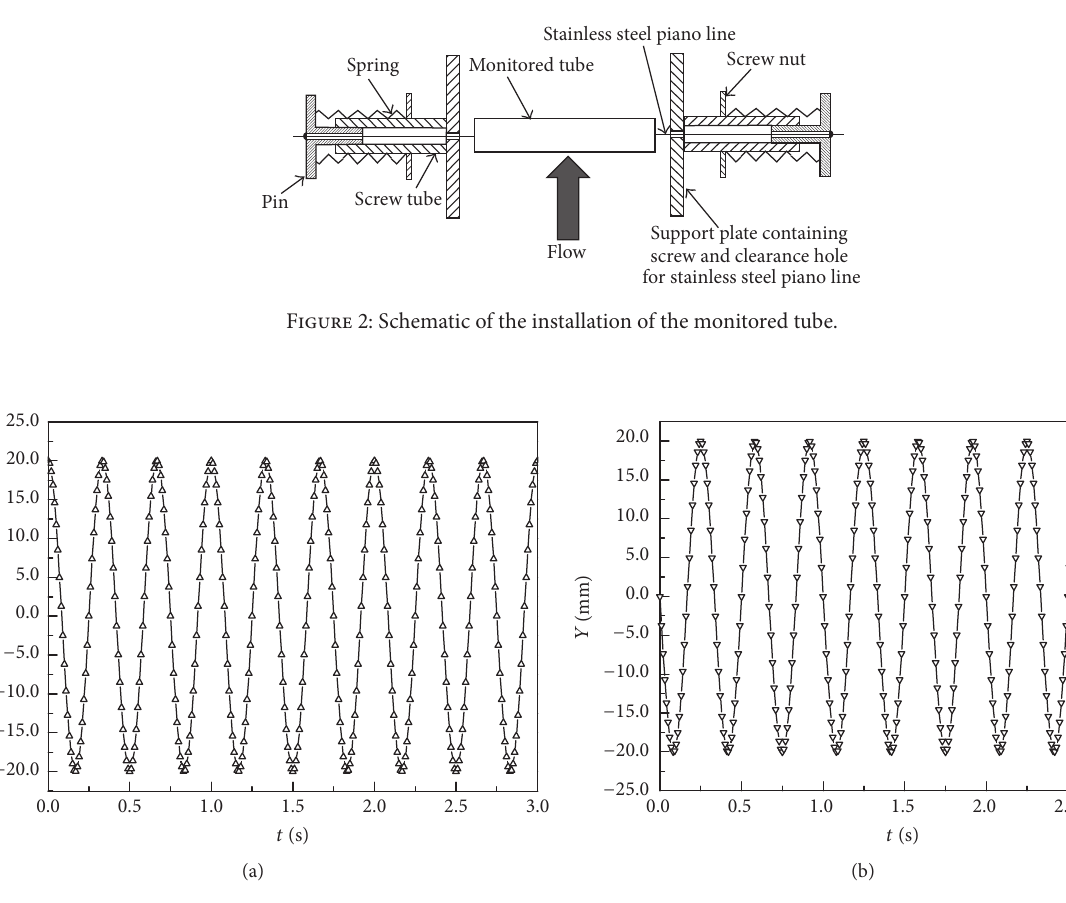
Figure 3: Typical time-history curves at the time for calibration of two acceleration transducers. (a) In-line direction and (b) transverse